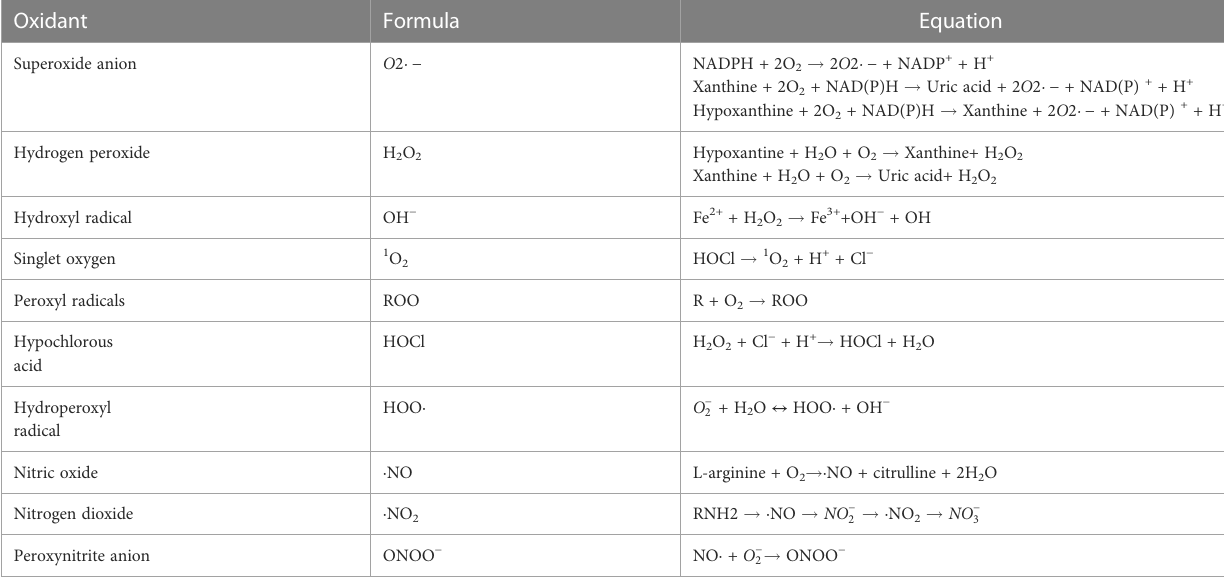
TABLE 1 Formation of major